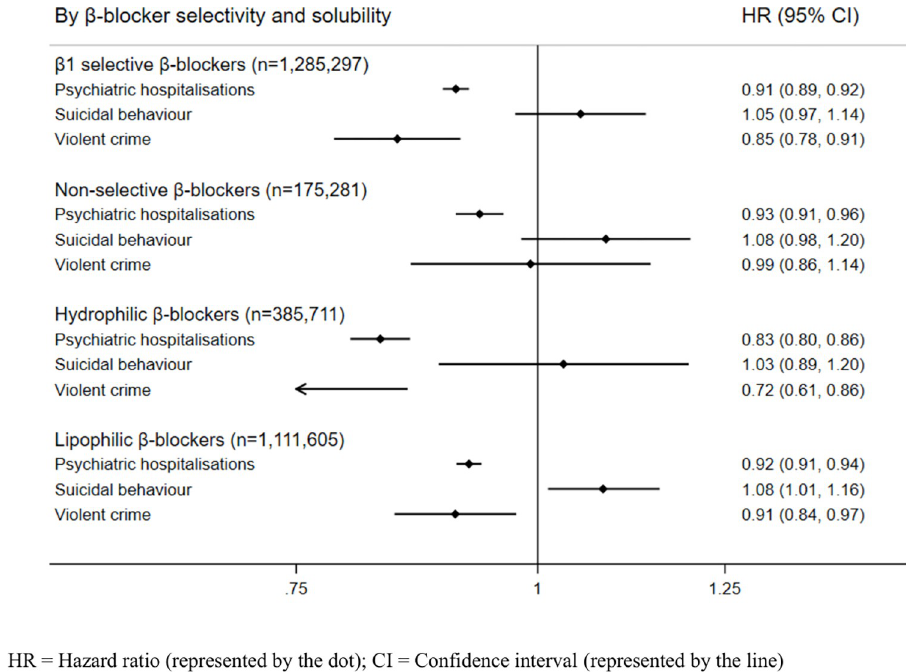
Fig 3. Age-adjusted within-individual associations between β -blockers and psychiatric and behavioural outcomes stratified by β -blocker selectivity and solubility. CI, confidence interval; HR, hazard ratio.